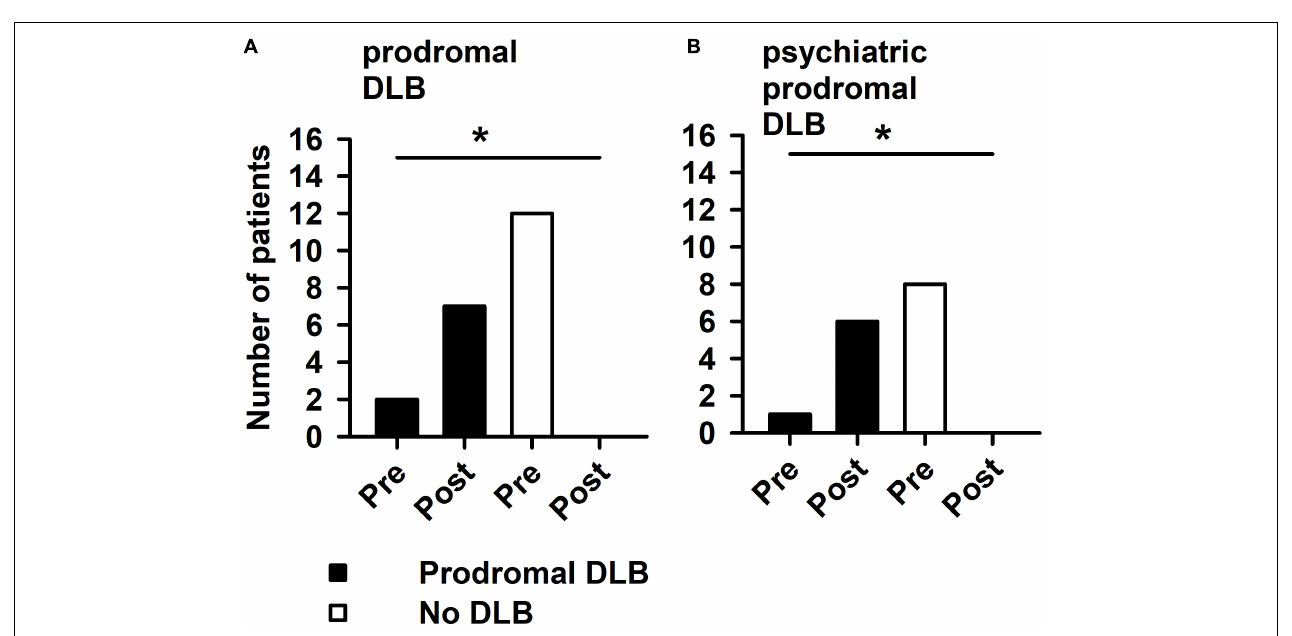
FIGURE 2 | Prodromal DLB patients are increased after 123I-FP-CIT SPECT imaging. 123I-FP-CIT SPECT led to increased number of prodromal DLB patients in comparison with non-DLB patients in our psychiatry cohort in (A) and in psychiatric-phenotypology patients in (B) . *with horizontal line: hereby a significant difference between groups ( A: number of patients with probable DLB pre-123I-FP-CIT SPECT vs. the number of those with probable DLB post-123-FP-CIT SPECT; B: number of patients with probable psychiatric DLB pre-123I-FP-CIT SPECT vs. the number of those with probable psychiatric DLB post-123-FP-CIT SPECT) ( p < 0.05 Fisher’s exact test) is indicated. DLB was diagnosed twice—before and after the 123-FP-CIT-SPECT.